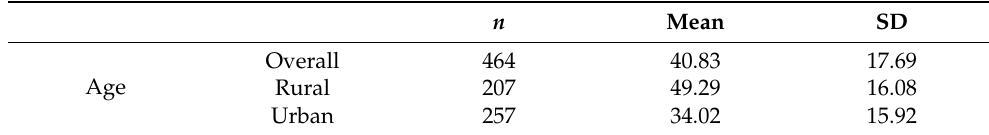
Table A1. Participants’ Mean Age with SD.